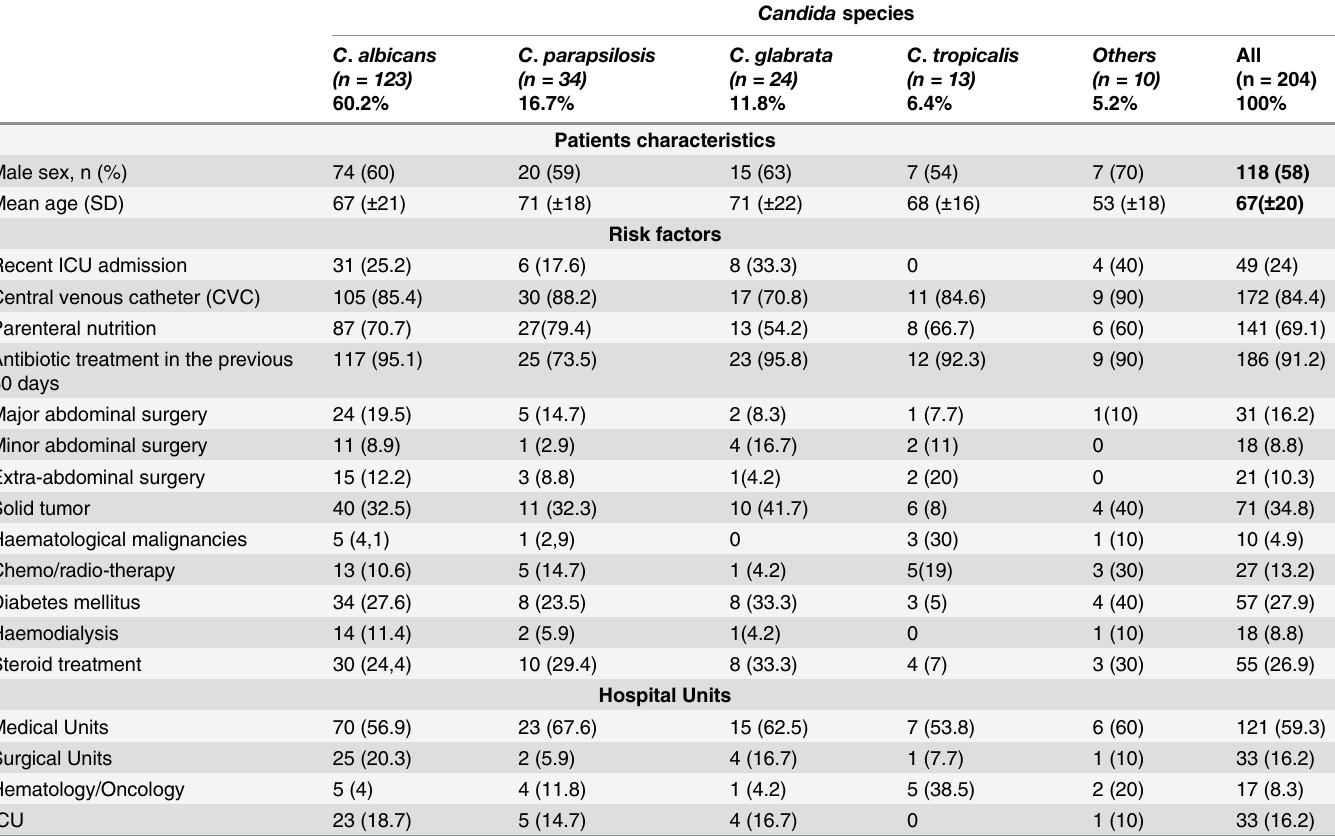
Table 1. Patients ’ features and ward distribution among candida species (n =